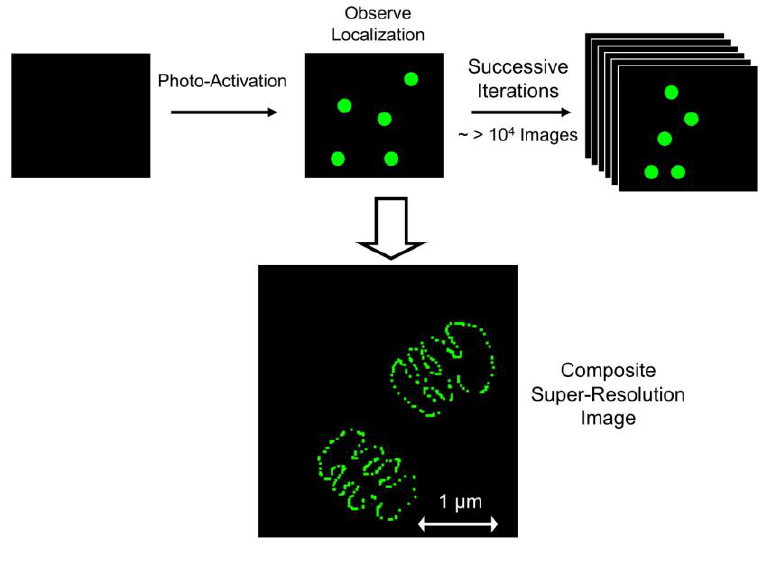
Figure 5. Super-resolution microscopy. Super-resolution microscopy obtains fluorescence- based spatial information with sub-diffraction (<200 nm) resolution. This is accomplished by using photo-activatable (PALM/fPALM) or photo-switchable (STORM) fluorophores, such that a sparse, spatially-separated sub-population of fluorophores is active at any one time. Upon photo-activation of the sub-population, the positions of the well-separated fluorophores can be determined with high spatial resolution by mapping the center of the diffraction-limited fluorescence signal. The activated fluorophores are then de-activated either by photobleaching (PALM/fPALM) or photo-switching, and a different sub-population is activated and localized. By repeating this process thousands of times, a composite, super-resolution image can be constructed using the mapped position of every